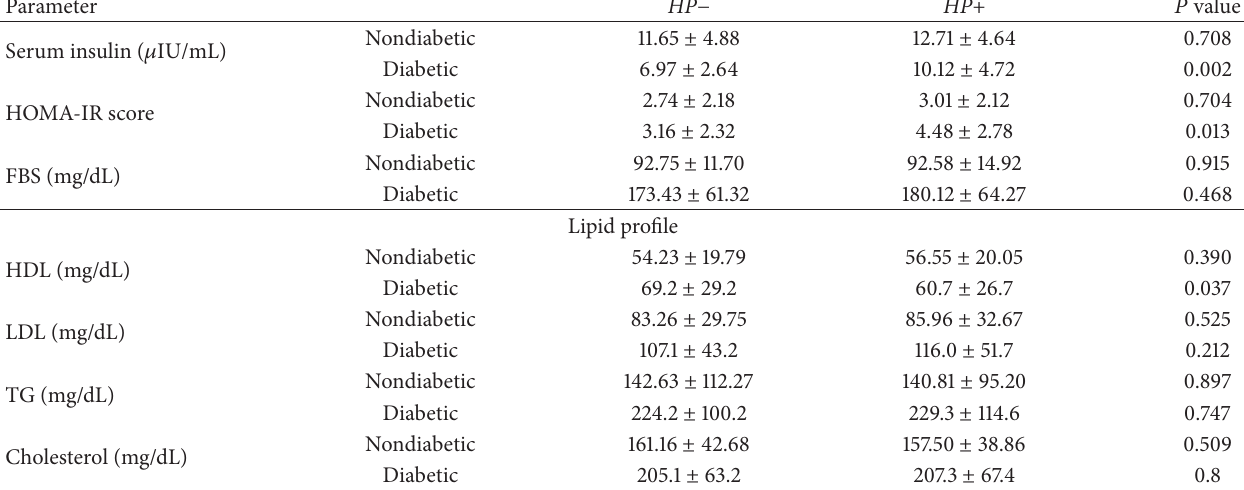
Table 2: Insulin resistance, glycemic control, and medication type in patients with respect to seropositivity for HP